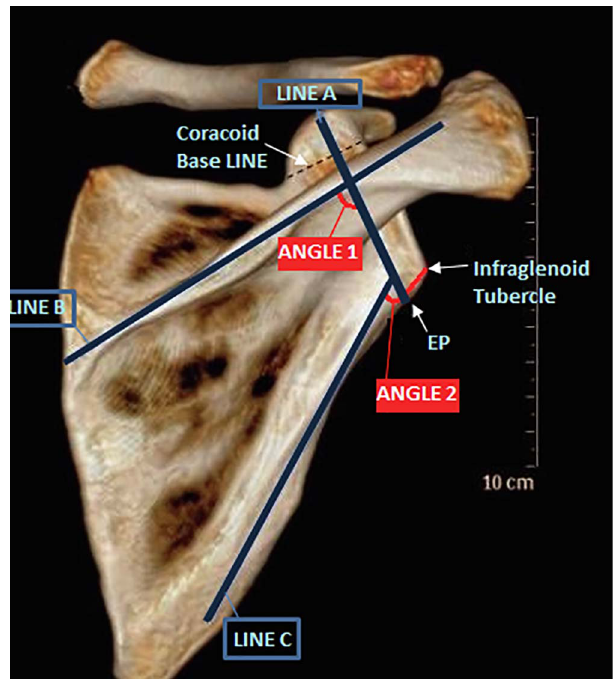
Figure 1. Coronal plane measurements. Entry Point (EP) is the point where line A which bisects the basal coracoid line and extends perpendicular to it intersects the inferior margin of the scapular neck. The distance from this point to the infraglenoid tubercle was measured in millimeters. The screw trajectory was determined by angle 1 between line A and line B (the long axis of the scapular spine) and angle 2 between line A and line C (the lateral scapular